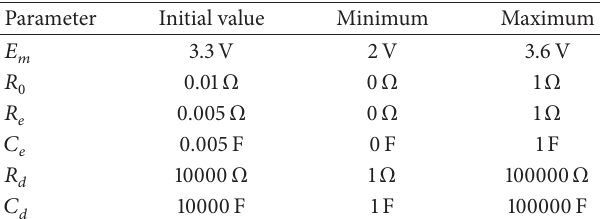
Table 1: Parameter